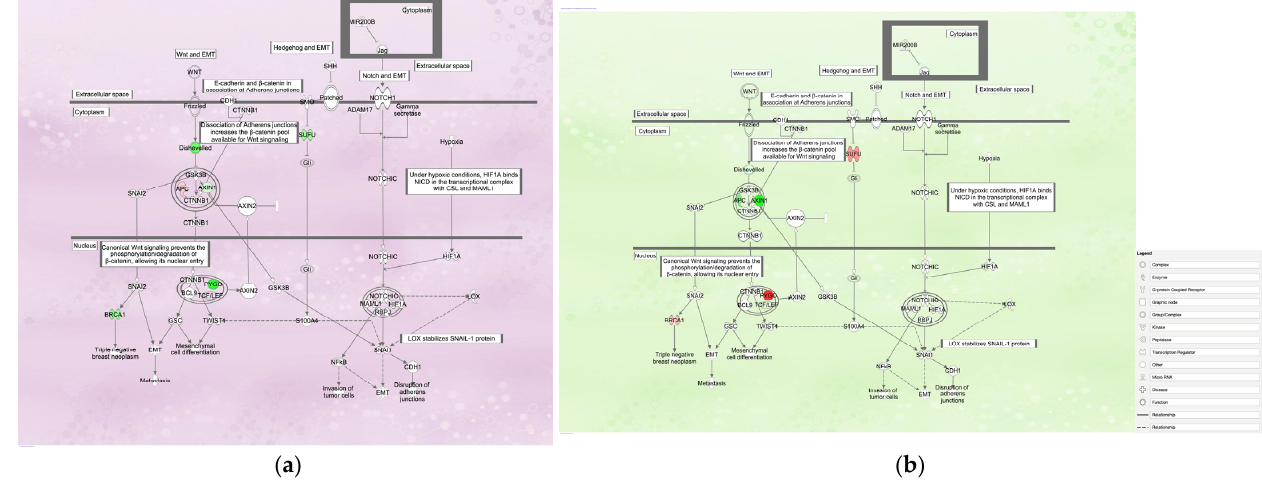
Figure 1. Regulation of the epithelial–mesenchymal transition (EMT) in development pathway in diffuse- and intestinal-type gastric cancer (GC). ( a ) Gene expression alteration in diffuse-type GC in regulation of the EMT in development pathway; ( b ) Gene expression alteration in intestinal-type GC in regulation of the EMT in development pathway. Red or green color indicates upregulated or downregulated genes, respectively. The intensity of colors indicates the degree of up- or downregulation. A solid or dashed line indicates direct or indirect interaction, respectively.